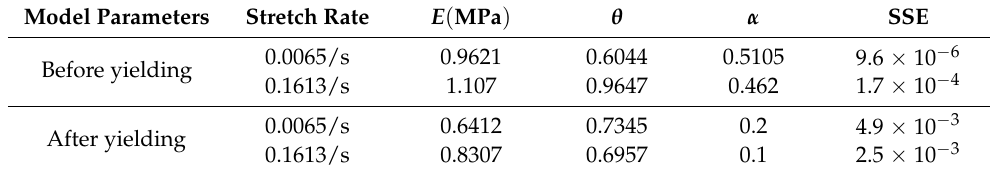
Table 4. Derived model parameters of data fitting of the variable-order (VO) fractional model. Model